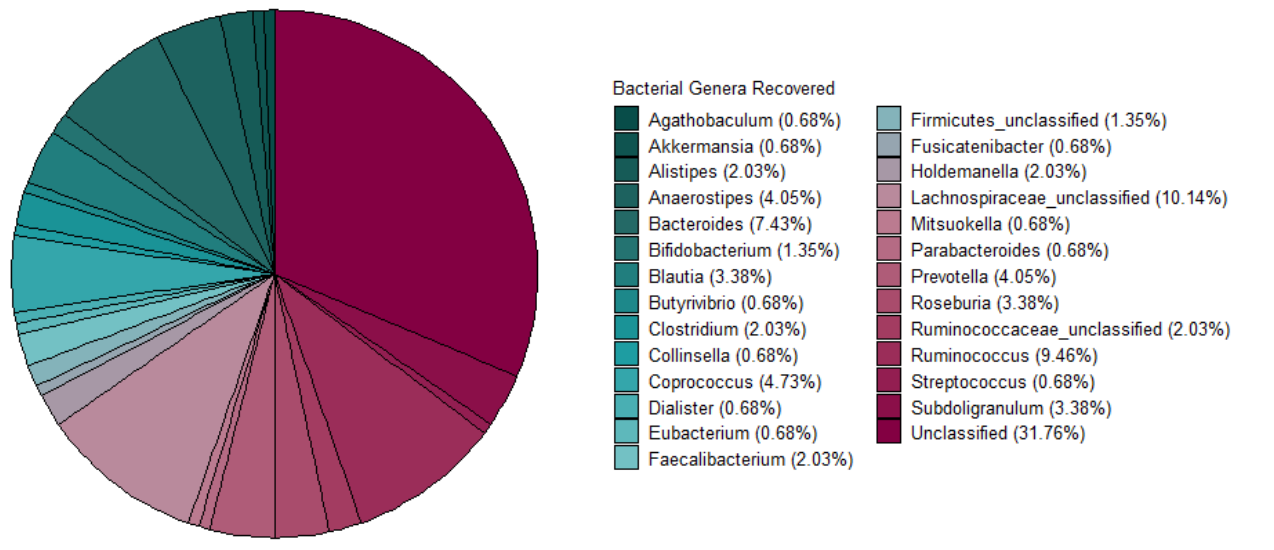
Figure 2. Bacterial genera recovered from Metagenome Assembled Genomes . The majority of MAGs were unclassified, followed by a high abundance of; Lachnospiraceae_unclassified , Bacteroides , Ruminococcus, and Coprococcus, using PhyloPHhlAn3 to assign taxonomy.